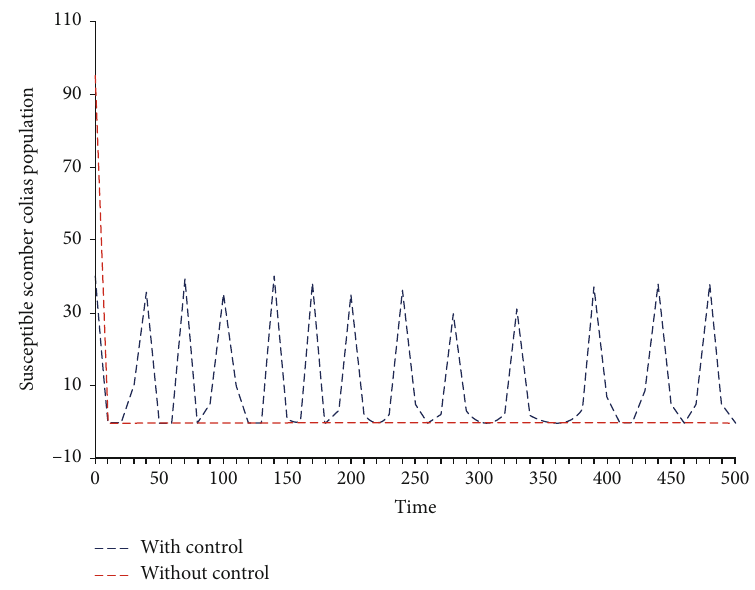
Figure 13: Susceptible Scomber colias population with optimal harvesting and e ff ort harvesting, with high e ff